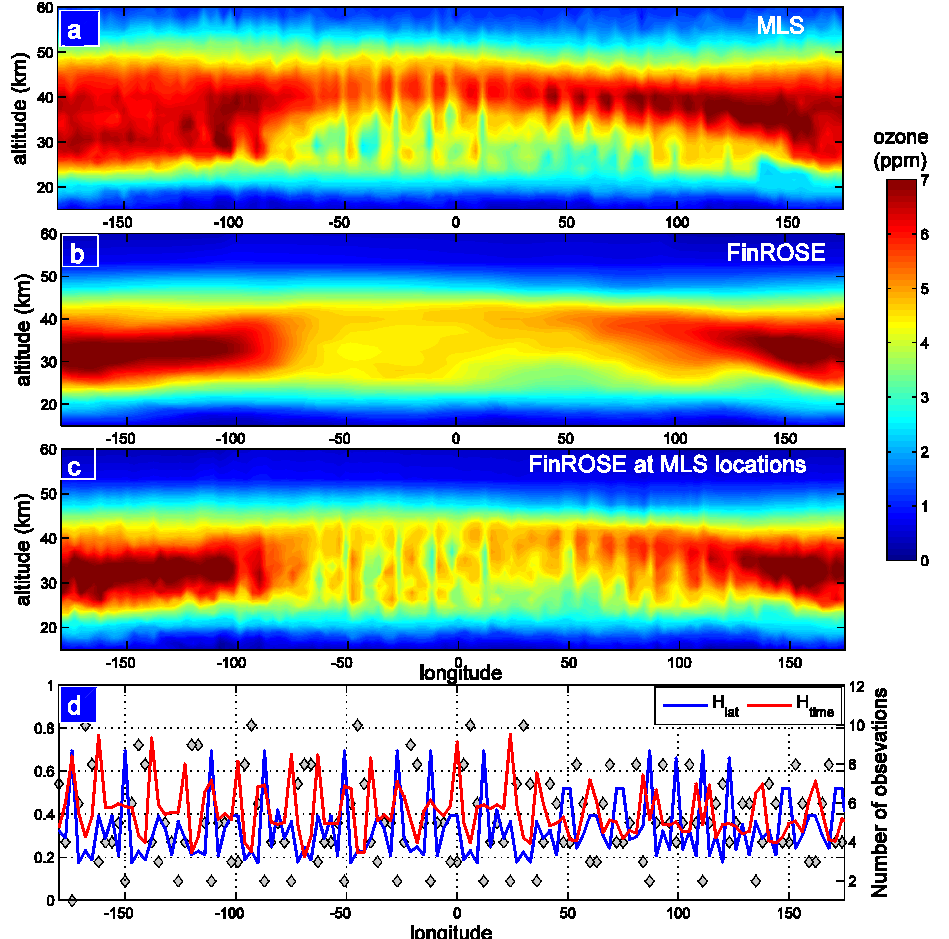
Figure 1. (a) Ozone mixing ratio from MLS observations at 60–70 ◦ N on 14–16 October 2007, averaged in 3 ◦ longitude bins; (b) the mean Fig. 1. (a): ozone mixing ratio from MLS observations at 60 ° N -70 ° N on 14-16 Octo- FinROSE field for 14–16 October 2007 at latitudes 60–70 ◦ N; (c) the FinROSE ozone field sampled at MLS locations, for the same dates ber 2007, averaged in 3 ° longitude bins. (b): the mean FinROSE field for 14-16 Octo- 14–16 October 2007 and averaged in the same way as the MLS data; and (d) number of observations (grey diamonds) and inhomogeneity ber 2007 at latitudes 60 ° N -70 ° N. (c): the FinROSE ozone field sampled at MLS lo- measures in latitude H lat and in time H time , for each longitude cations, for the same dates 14-16 October 2007 and averaged in the same way as the MLS data. (d): number of observations (grey diamonds) and inhomogeneity H and in time H , for each longitude bin. measures in latitude lat time